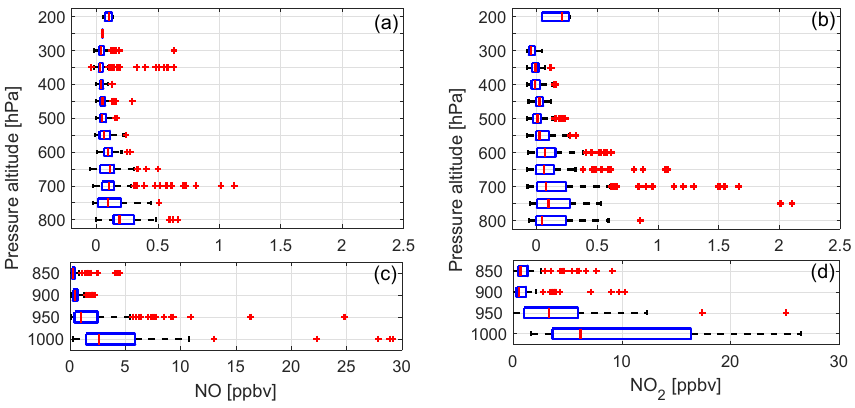
Figure 13. Statistical vertical distribution of NO and NO 2 (only at daytime) for (a, c) NO and (b, d) NO 2 over Düsseldorf Airport in summer (JJA) 2015. Note the different x -axis